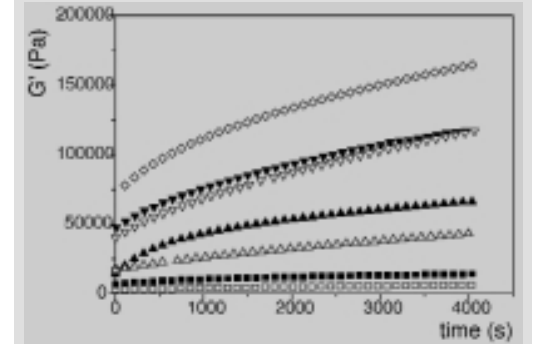
Figure 10 (left above): Stor- age modulus at 0.1 rad/s versus reaction time at 180°C for MAH1/GMA1 50/50 blend and different values of the preshear g R at 105°C: 500 ( Û ), 1000 ( Ú ), 2000 ( ı ), 5000 ( Ù ), 10 000 ( Ì ). Same curve for NR1/GMA1 50/50 blend with a preshear of g R = 5000 at 105°C ( ¥ ). Figure 11 (right above): Stor- age modulus at 0.1 rad/s versus reaction time at 180°C for MAH1/GMA1 blends at different composi- tions. The preshear was the same for all samples ( g R = 5000): 50/50 ( Ì ), 66/34 ( ı ), 34/66 ( Ù ), 80/20 ( Û ), 20/80 ( Ú ), 90/10 ( · ). Figure 12 (left below): Stor- age modulus at 0.1 rad/s versus reaction time at 180°C for MAH1/GMA 50/50 blends with different reac- tivities of the GMA phase. The preshear was the same for all samples ( g R = 5000): GMA1 ( Ì ),GMA2 ( Ù ), GMA3 ( ı